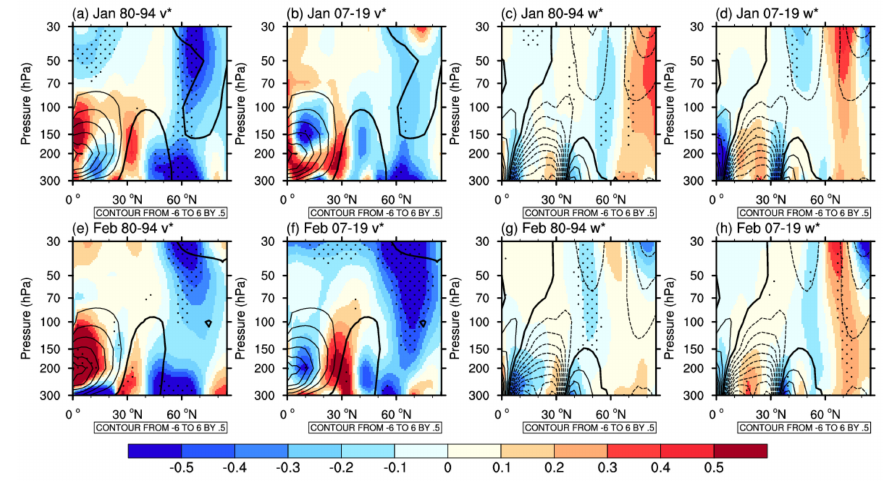
Figure 9. Regression of ( a , b ) v ∗ (shading: 10 − 1 m s − 1 ) and ( c , d ) w ∗ (shading: 10 − 3 m s − 1 ) on AO index in January during ( a , c ) 1980–1994 and ( b , d ) 2007–2019. ( e – h ) Same as ( a – d ), but for the anomalies in February. The line contours represent the climatologies of ( a , b , e , f ) v ∗ (m s − 1 ) and ( c , d , g , h ) w ∗ (10 − 3 m s − 1 ) in corresponding month. The values over the stippled regions are statistically significant at the 95% confidence level.